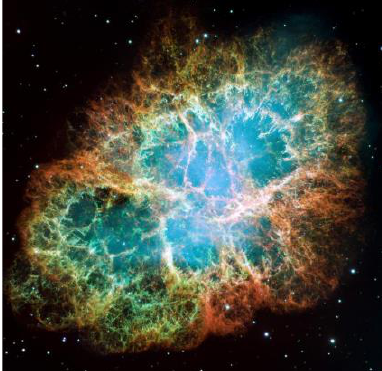
Figure 5. The Crab Nebula photographed by the Hubble Space Telescope [https://commons.wiki- media.org/wiki/File:Crab_Nebula.jpg, accessed on 1 August 2022].